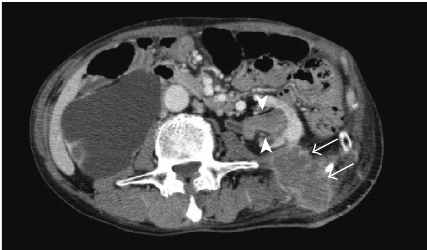
Figure 2: Computed tomography (CT) of the tumors. Abdominal CT scan showing a tumor in the left pelvis (arrowhead) and a soft tissue mass along the former nephrostomy tract